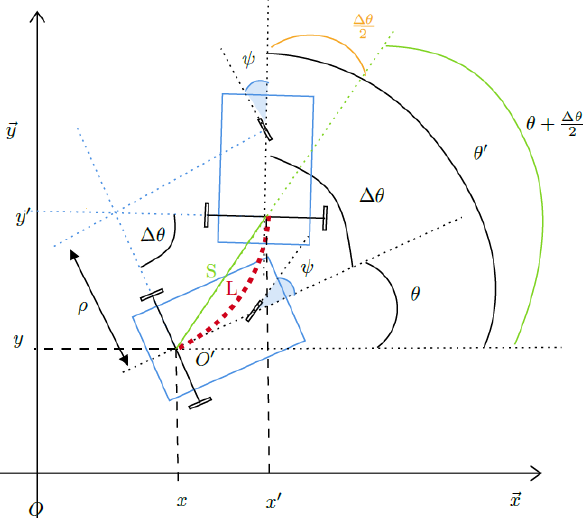
Figure 1. Three-wheeled vehicle model in